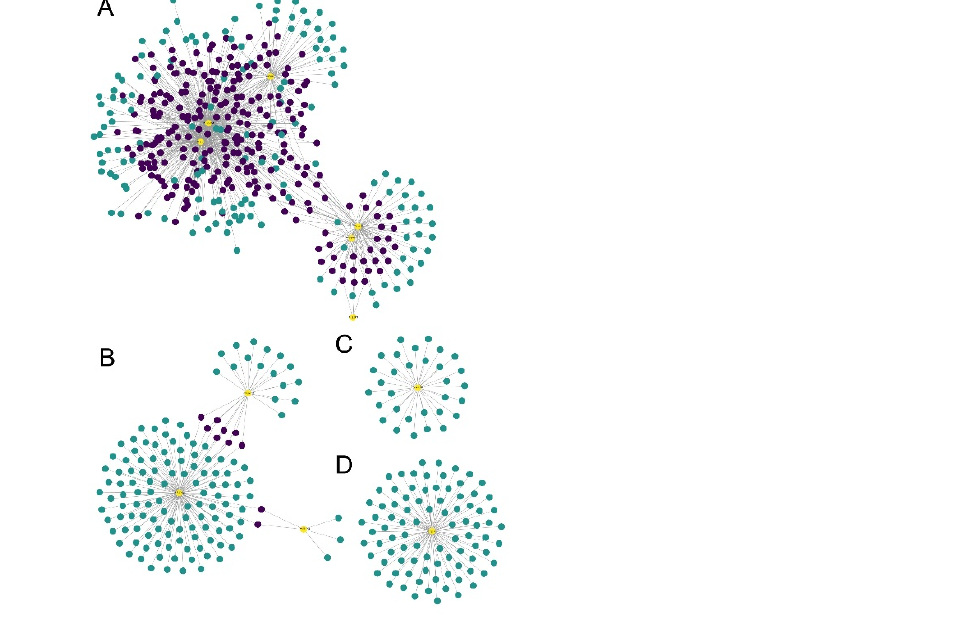
Figure 9. The co-expression networks of pepper SBP genes. Four networks were obtained and shown in ( A – D ).